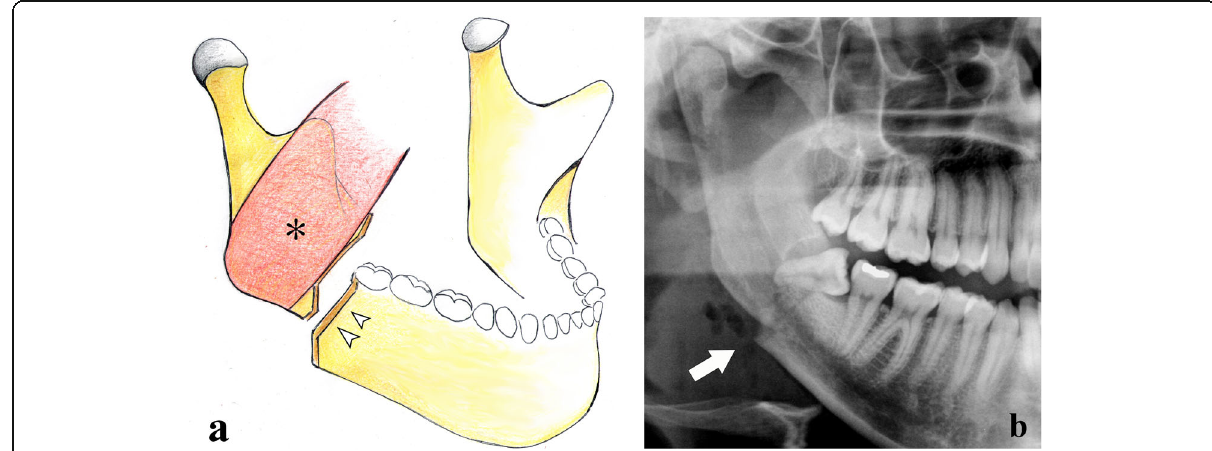
Fig. 5 Angle fracture. a Picture showing a vertical fracture that runs distally to the third molar (arrowheads). It is a displaced fracture since the masseter muscle (asterisk) pulls the distal bone fragment upwards and medially. b Cropped panoramic radiograph. Mandibular angle fracture involving an impacted third molar